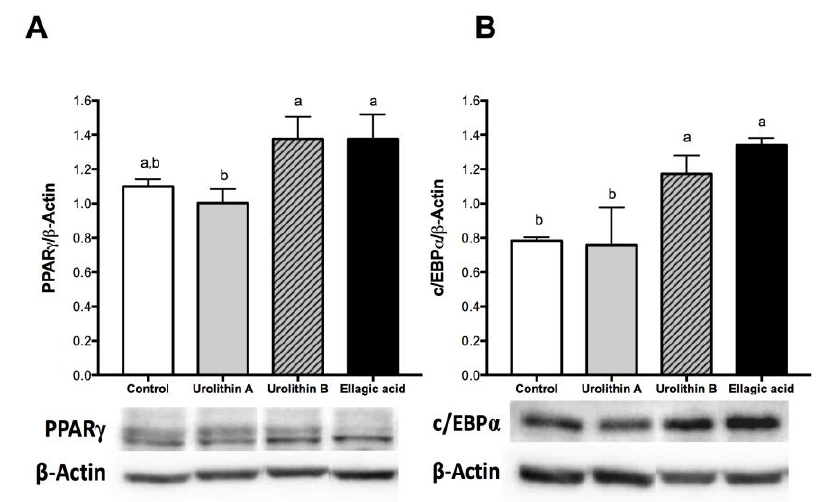
Figure 4. Effect of ellagic acid, urolithin A, and urolithin B in the protein expression of PPARγ ( A ) and CCAAT-enhancer-binding protein alpha (c/EBPα) ( B ) in 3T3-L1 adipocytes. The protein expression of PPARγ and c/EBPα were determined by Western blot after 8 days of treatment with 25 µM of the compounds, as described in the Materials and Methods section. The values represent the mean ± SD ( n = 3) of three independent experiments. Different letters among bars denote significant changes among treatments and control ( p ≤ 0.05) performed by ANOVA and Tukey’s post hoc test.